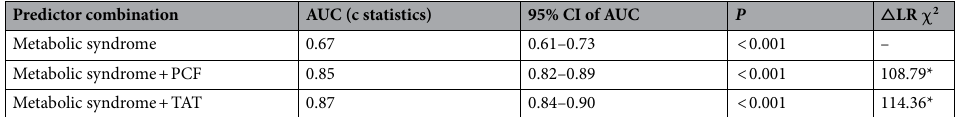
Table 4. The incremental values of pericardial fat (PCF), thoracic peri-aortic adipose tissue (TAT) beyond metabolic syndrome in discriminating fatty liver diagnosis. AUC area under the ROC curve, CI confidence interval, LR likelihood ratio, which indicates reduction in deviance from the Metabolic syndrome only model; * indicates P values of delta LR test < 0.001. PCF pericardial fat, TAT thoracic peri-aortic adipose tissue.